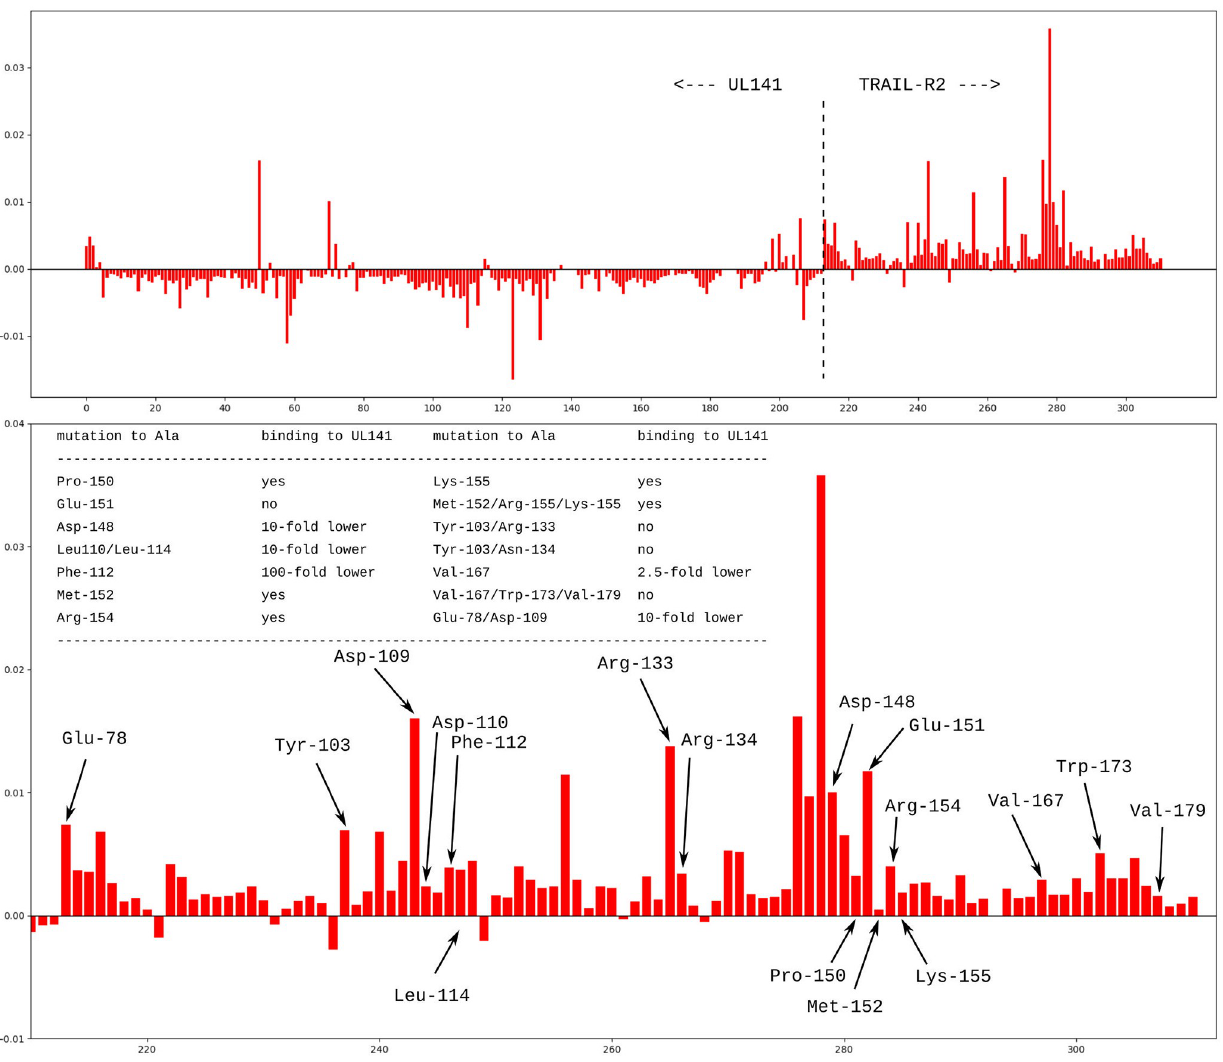
Fig 5. NDA predictions and experimental data. The NDA D C eff scores for the residues in the UL141 ... TRAIL-R2 complex based on an FMO/DFTB k calculation. The top panel shows the scores of residues in both proteins (the border is depicted by the dashed line) and the bottom is a detailed plot for the residues of the TRAIL-R2 protein. The table contains experimental SPR (surface plasmon resonance) data published elsewhere [87]. Specific site mutations in the TRAIL-R2 protein to alanine (so called alanine scan), resulted in altered stability of the complex. The NDA bars corresponding to the residues that were mutated in the SPR experiments are